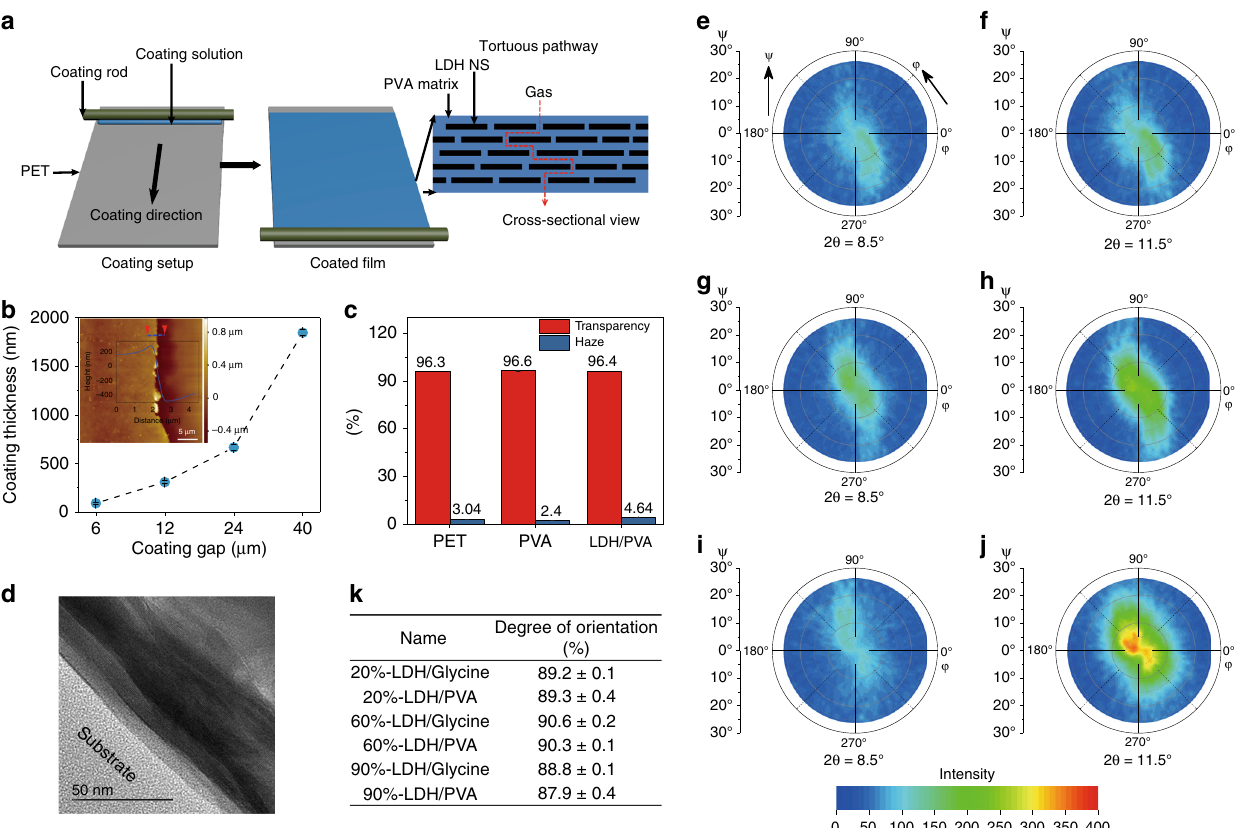
Fig. 2 Structure of barrier fi lms containing LDH nanosheets. a Schematic of coating process and tortuous pathway. The coating solution was spread and coat on the substrate PET fi lm by a semi-automatic bar coater to form the aligned structure of LDH NS in PVA matrix. The well aligned impermeable LDH forces gas molecules to go through a tortuous pathway to diffuse through the fi lm. b Coating layer thickness plotted as a function of coating gap. Error bar represents the standard deviations of more than 10 measurements. The inset shows the coating layer thickness of fi lm coated with 24 μ m coating gap measured by AFM. The coating solution used to coat all the fi lms contains 3 wt% LDH NS and 2 wt% PVA. c Transparency and haze of the barrier fi lms of PET, 10 wt% PVA coated PET, and 10 wt%-60% LDH coated PET fi lms. d Cross-sectional TEM image of the barrier fi lm containing 60% LDH showing ordered structure where LDH nansheets are aligned parallel to each other. Pole fi gure measurements of LDH/PVA phase and LDH/Glycine phase in the barrier fi lms (all the fi lms were coated with 24 μ m gap) containing 20% ( e , f ), 60% ( g , h ) and 90% LDH ( i , j ) in the coating layer. k Summary of degree of orientation of LDH nanosheets calculated by Eq. (3). Error bar represents standard error from the curve fi tting. The total solid content of all the coating solutions (except in c ) were 5 wt% for all the coated fi lm samples discussed in this fi gure. PVA with MW of 67,000 g mol − 1 was used for all the coating fi PET, PVA coated PET and PVA/LDH NS coated PET, respectively (Supplementary Fig. 12). All three fi lms showed very similar temperature at the maximum decomposition rate ( T max ) of ca. 421 °C (Supplementary Table 4) 19 . The results suggest that